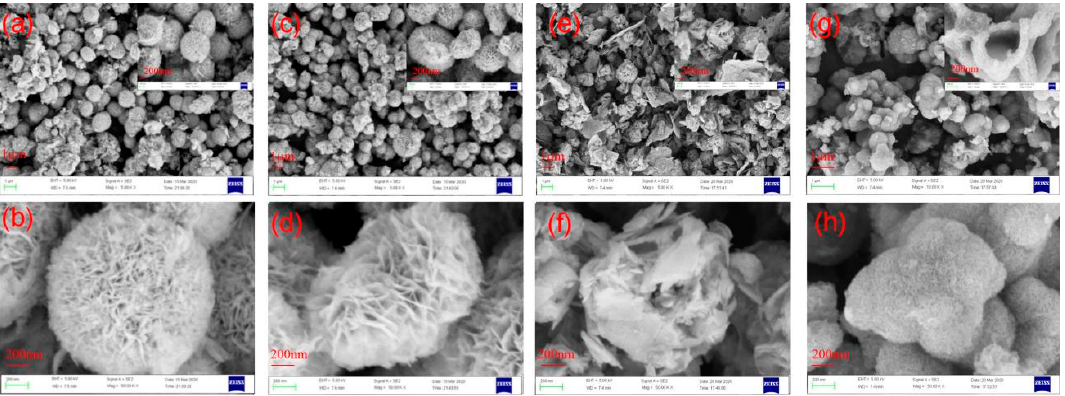
Figure 3. SEM images of RGO/BiOCl/TiO 2 nanocomposites with various TiO 2 contents: ( a,b ) 0%; ( c,d ) 10%; ( e,f ) 30%; and ( g,h ) 50%.